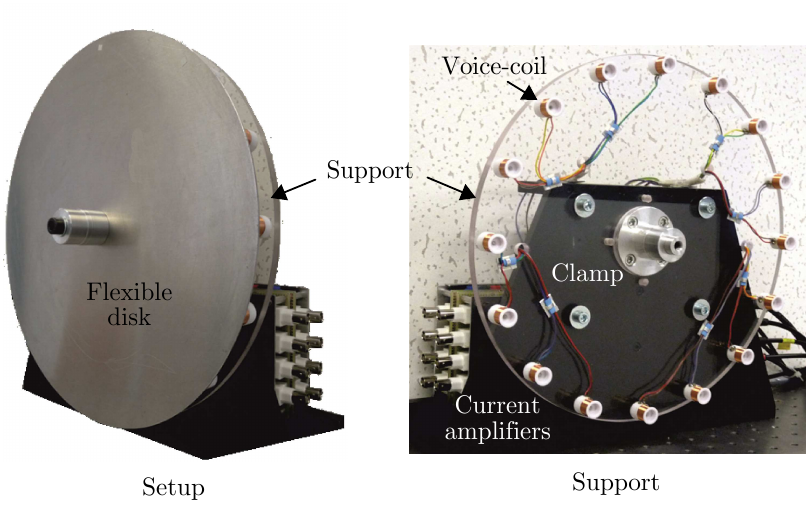
Figure 6. View of the experimental setup. ( Left ) Plate mounted on its central support; the PZT patches are located on the opposite side of the plate. ( Right ) Set of voice coils used to excite the